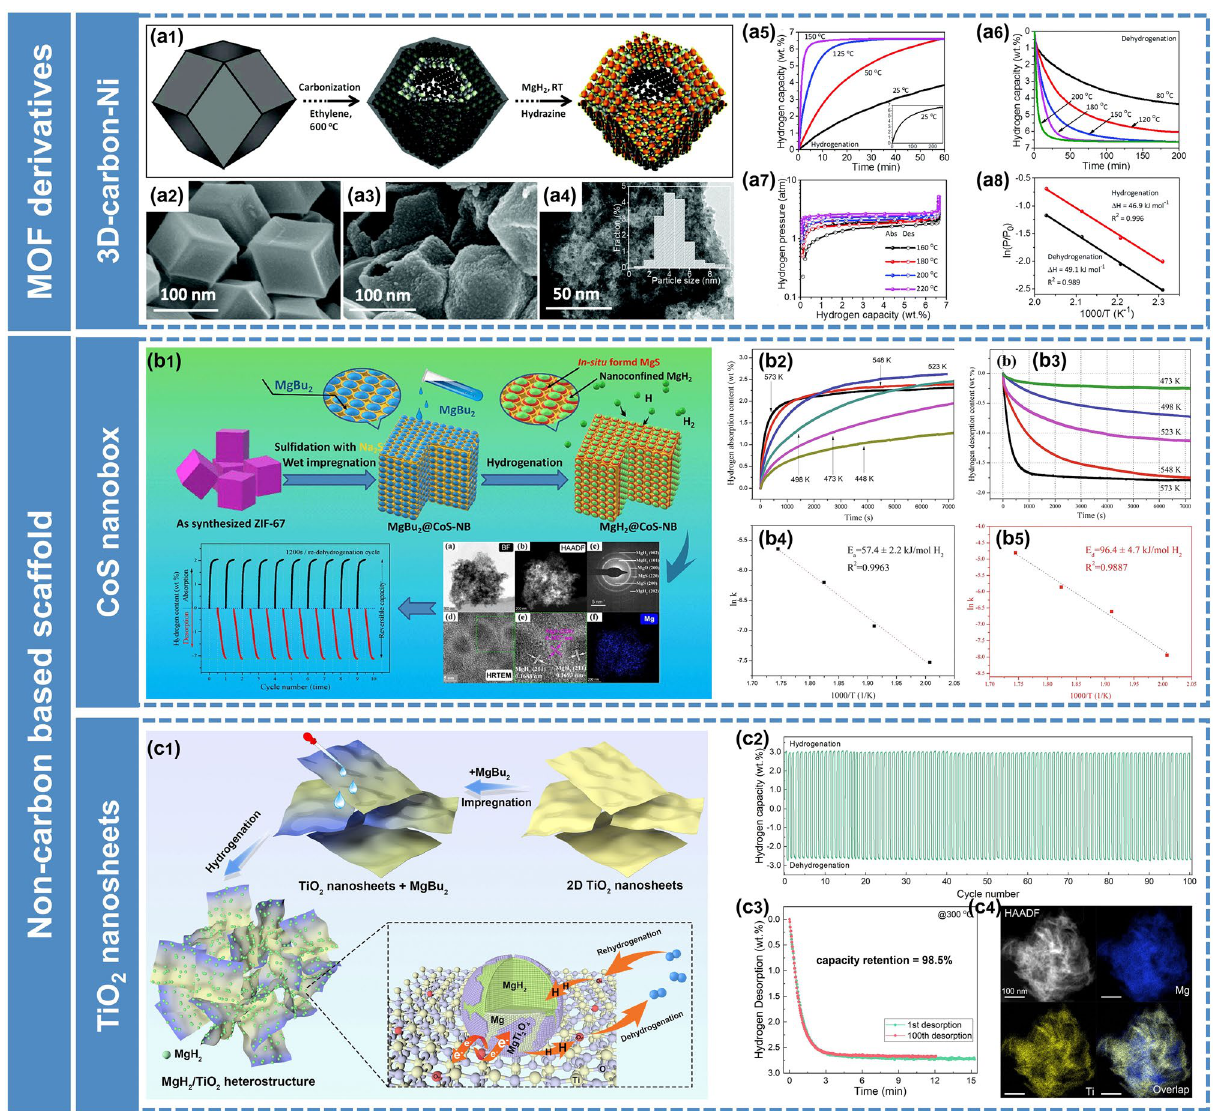
Fig. 10 Synthesis of nanostructured Mg-based composites through nano-confinement method. a1 Schematics displaying the self-assembled MgH 2 on 3D metal interacted carbon. a2 SEM image of the prepared metal-interacted 3-D carbon. a3 SEM and a4 TEM images of the MHCH-